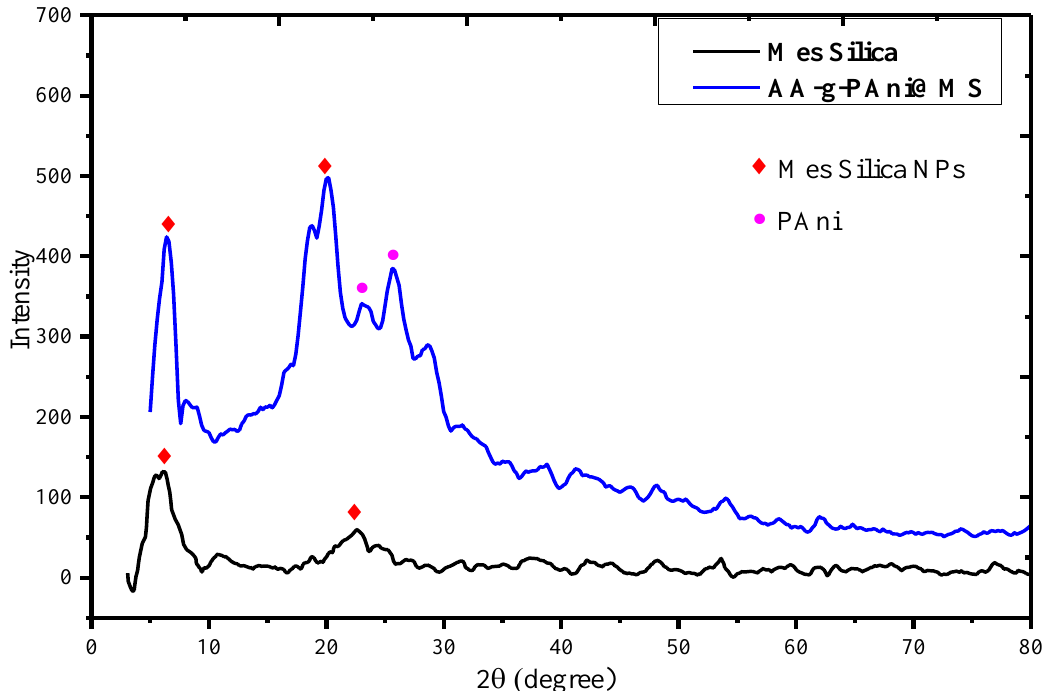
XRD spectra of mesoporous silica nanoparticles (black line) and AS-g-PAni@MS nanocomposite (blue line).